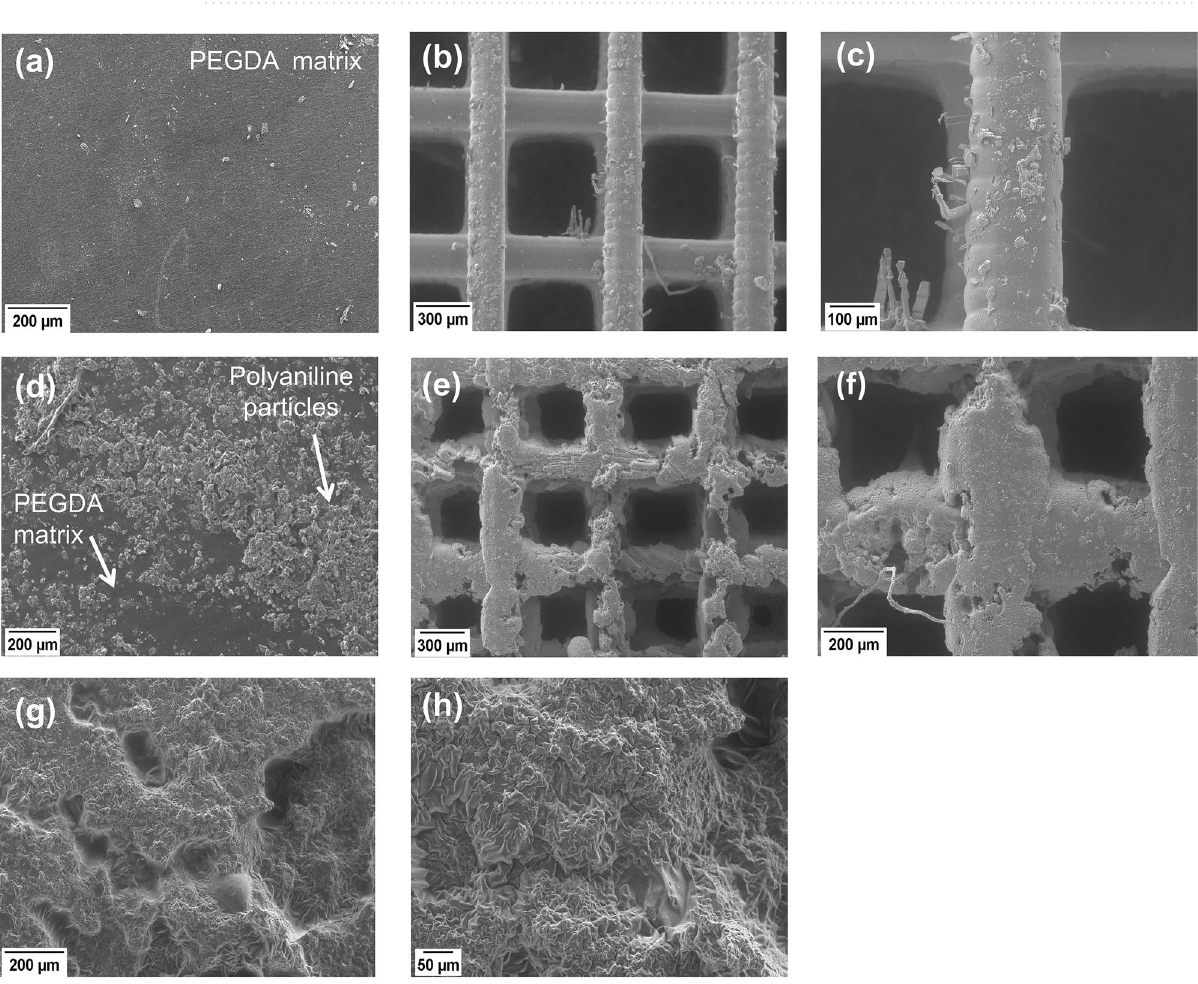
Figure 5. Morphology of the printed scaffolds. ( a ) Matrix of PEGDA without PANI, ( b ) Non-conductive PEGDA scaffold at 60X and ( c ) at 150X, ( d ) 2% PANI embedded in the PEGDA matrix, ( e ) conductive scaffold with 2% PANI at 50X and ( f ) at 100X, ( g ) wrinkly morphology indicates the homogeneous distribution of 3% PANI in the PEGDA matrix at 100X, and ( h ) at 200X